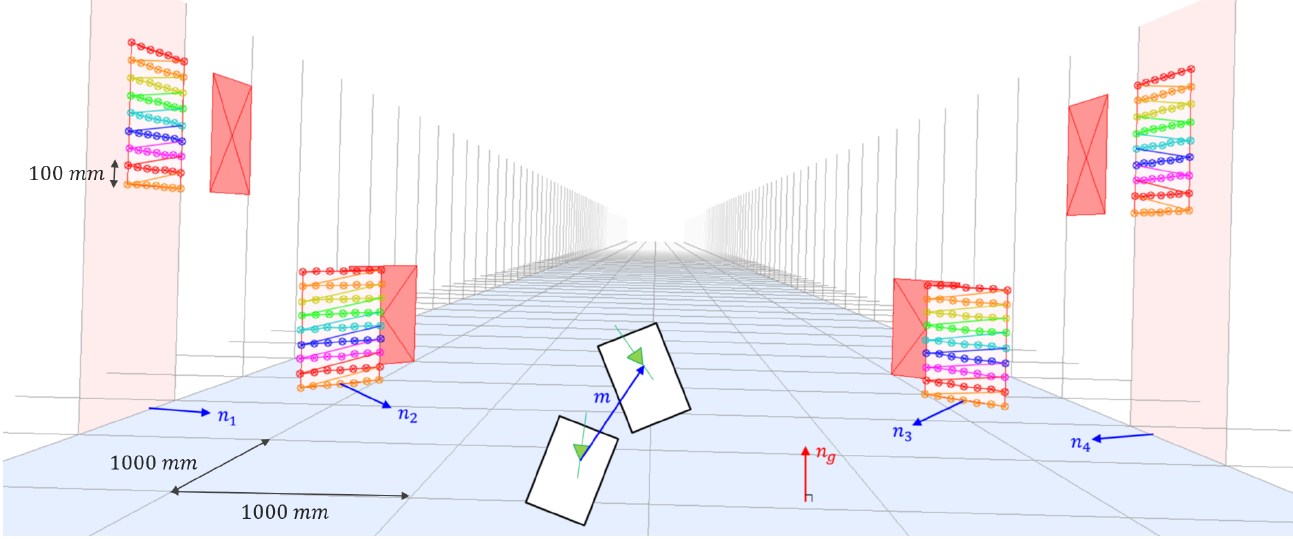
Figure 1. Synthetic simulation environment for multiple planar reconstruction and camera extrinsic